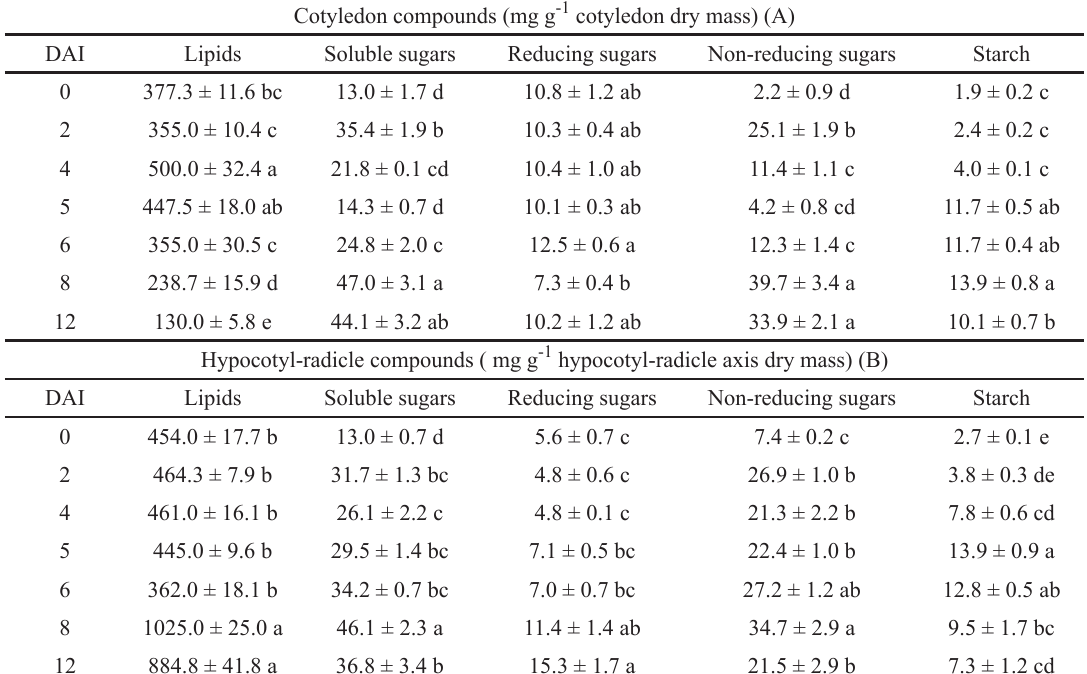
Changes in lipid, sugars (soluble, reducing and non-reducing) and starch contents in Cereus jamacaru seed cotyledons (A) and hypocotyl-radicle axis